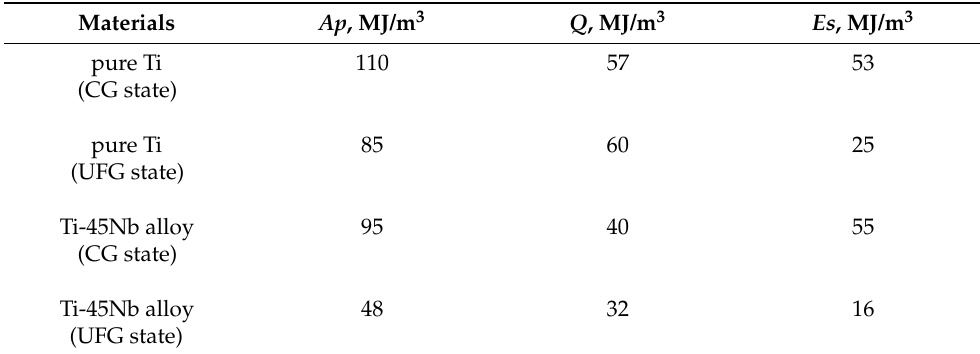
Table 2. Amount of specific energy released during uniaxial tension in the pure titanium and Ti- 45Nb alloy in the CG and UFG states.